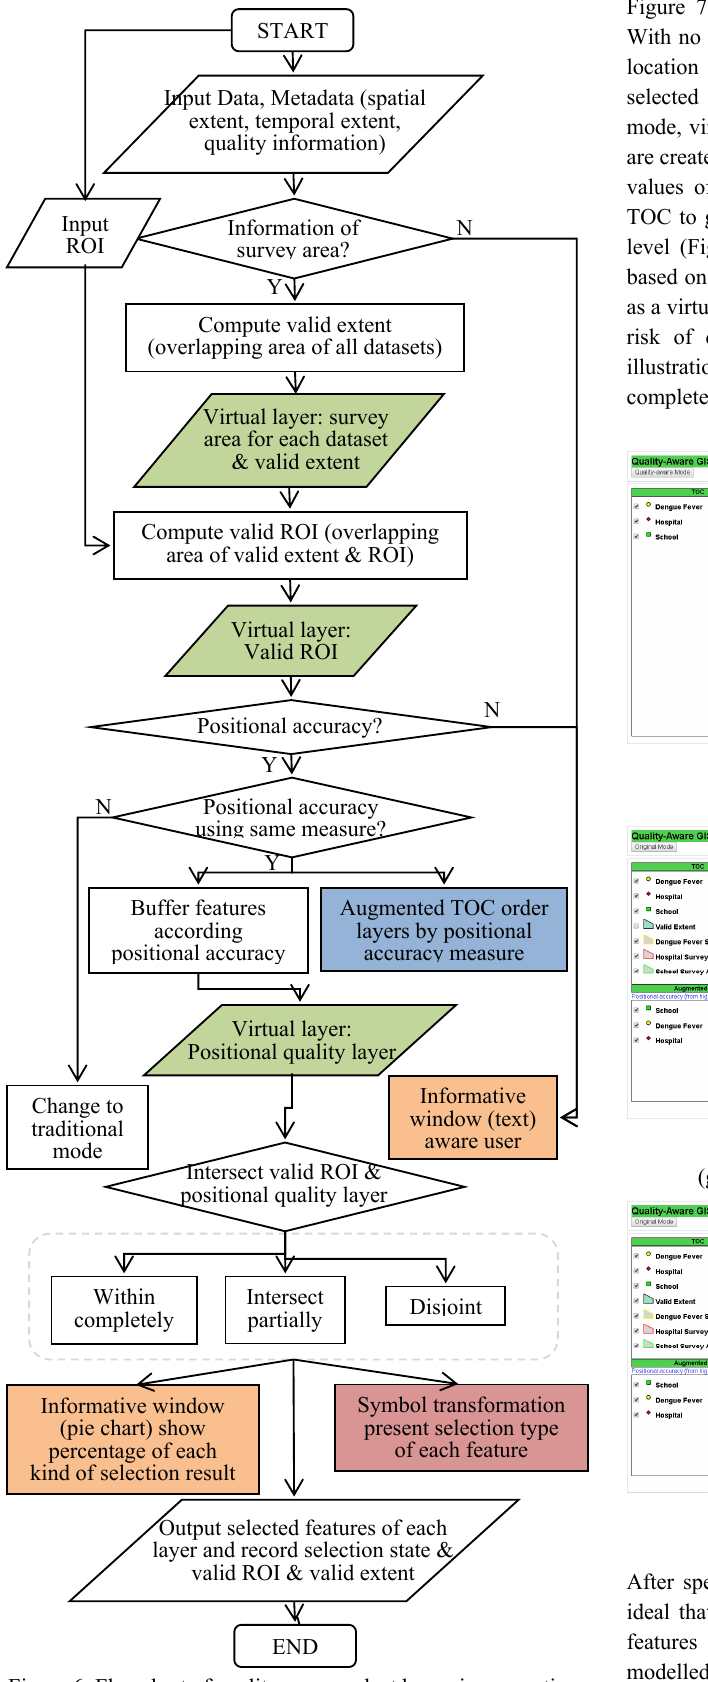
Figure 6. Flowchart of quality-aware select by region operation